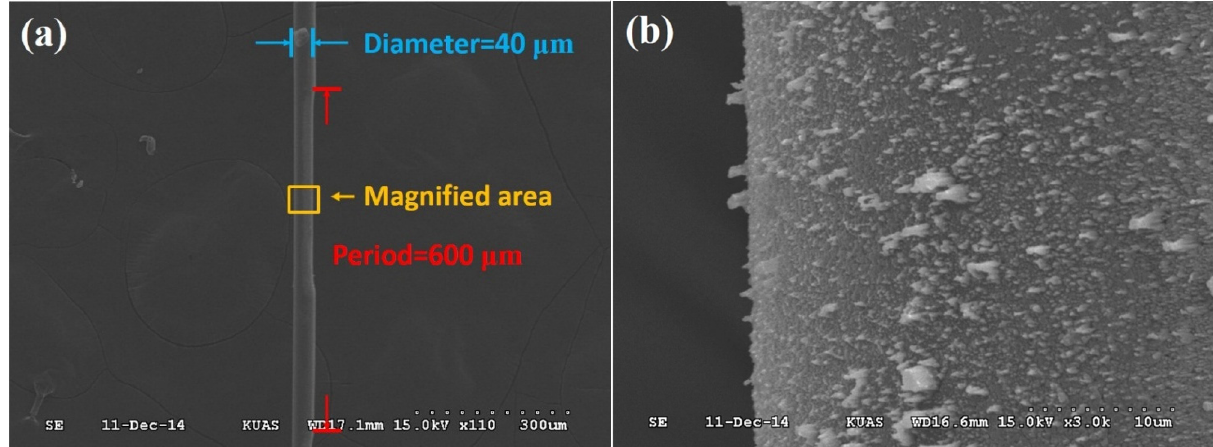
Figure 1. The fabrication process of the notched long-period fiber grating (NLPFG) sensor with the surface needle nanostructure.